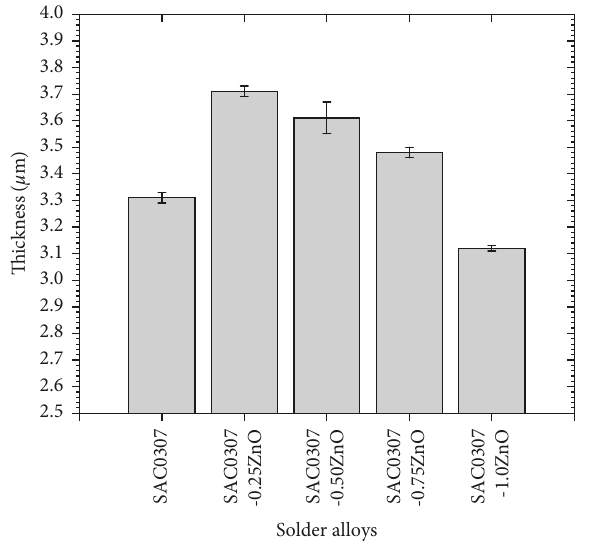
Figure 10: Thickness of Cu 6 Sn 5 between the SAC0307-xZnO and the copper